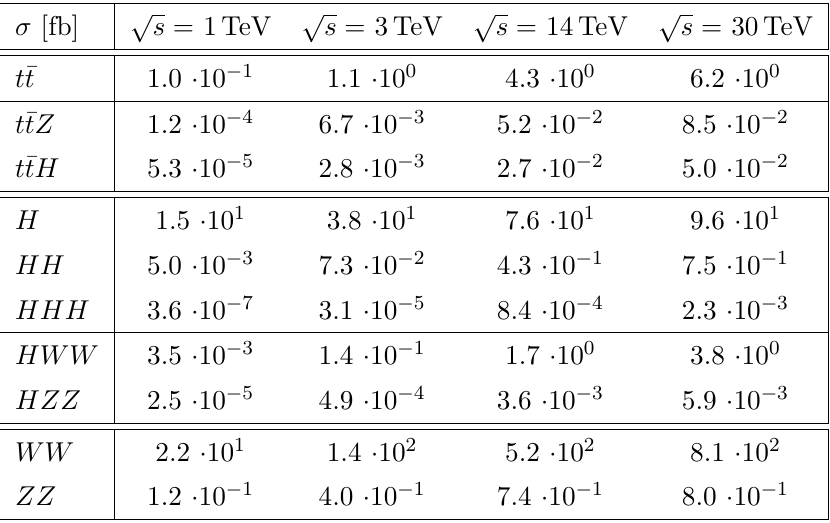
Table 3 . SM cross sections [fb] for sample ZZ=Z(cid:13)=(cid:13)(cid:13) fusion processes (with interference) in (cid:22) + (cid:22) (cid:0) collisions at representative collider energies